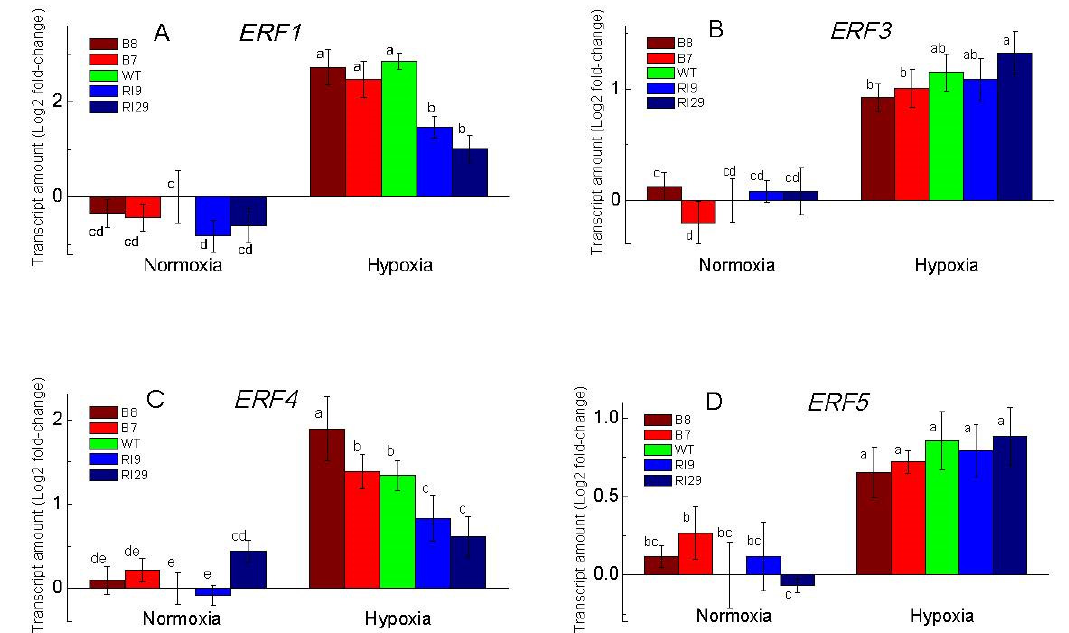
Figure 7. Transcript levels of the genes encoding different ethylene-responsive factors ERF1 ( A ), ERF3 ( B ), ERF4 ( C ), and ERF5 ( D ) in leaves of tobacco plants exposed to normoxia and 6 h of hypoxia. The plant lines used included the wild type (WT), two alternative oxidase overexpressors (B7 and B8), and two alternative oxidase knockdowns (RI9 and RI29). Vertical bars indicate the SD from three to four independent experiments ( n = 3–4); different letters indicate significant differences between five tobacco lines and the treatments.